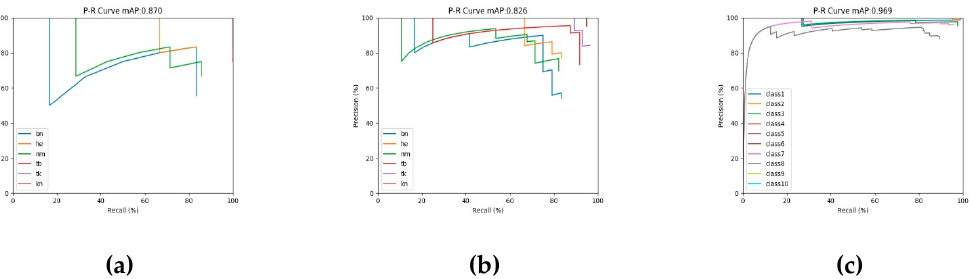
Figure 12. Loss function display of the proposed method on the Hong Kong dataset and DAGM2007 dataset. ( a ) The loss of the proposed method on the Hong Kong dataset in the training stage; ( b ) The loss of the proposed method on the DAGM2007 dataset in the training stage.